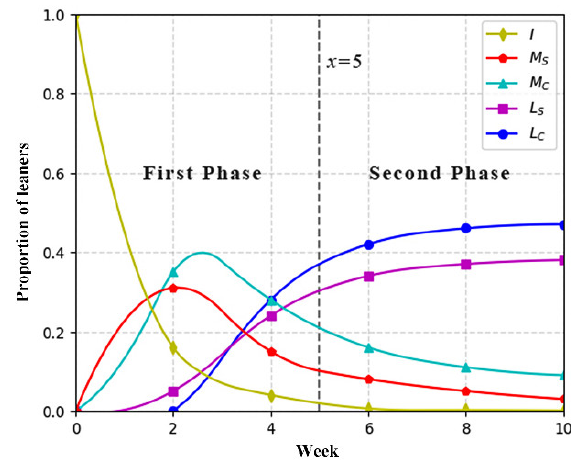
Figure 6. Collaborative state of control group.